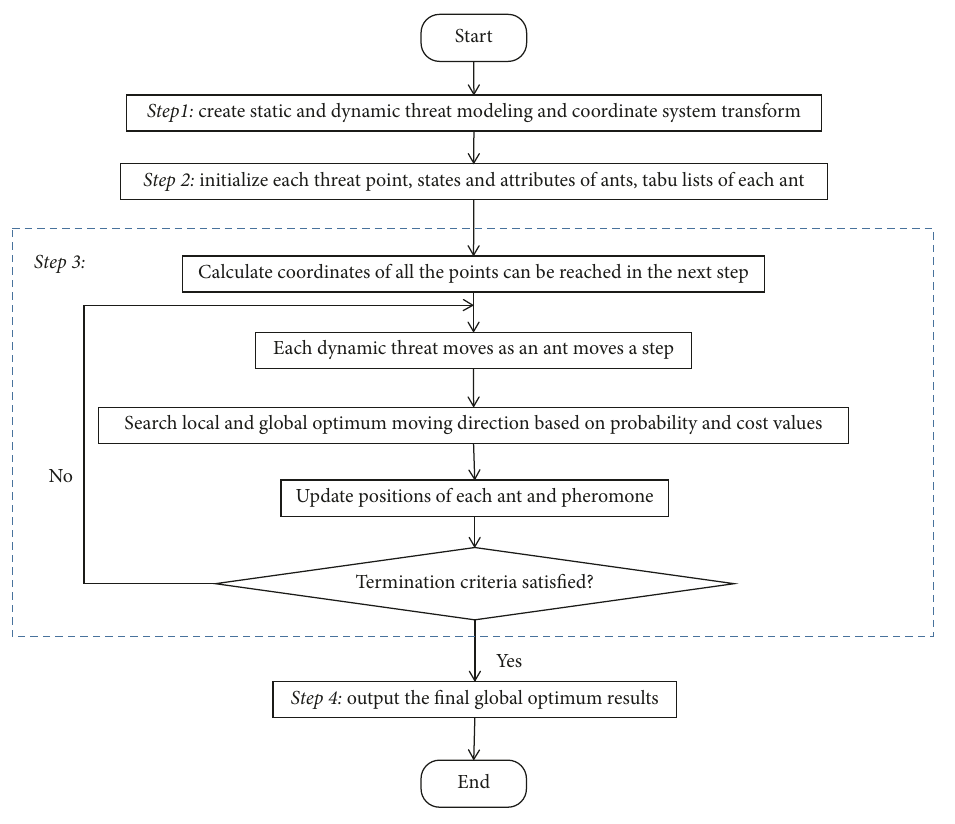
Figure 5: Flowchart of the proposed